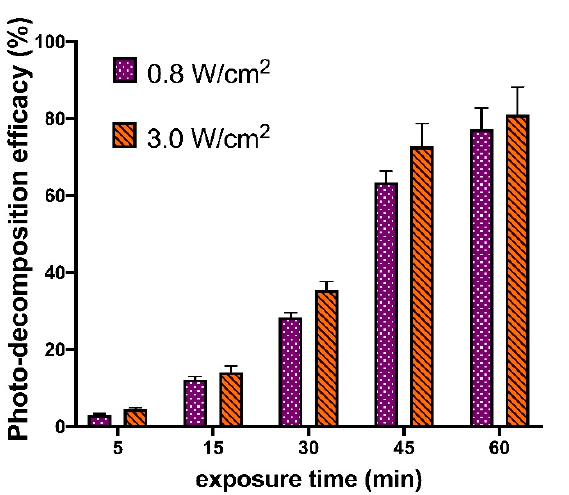
Figure 6. E ff ect of irradiation time and laser power on the e ffi cacy of 325 nm laser photo-induced linker decomposition in DMSO solution.